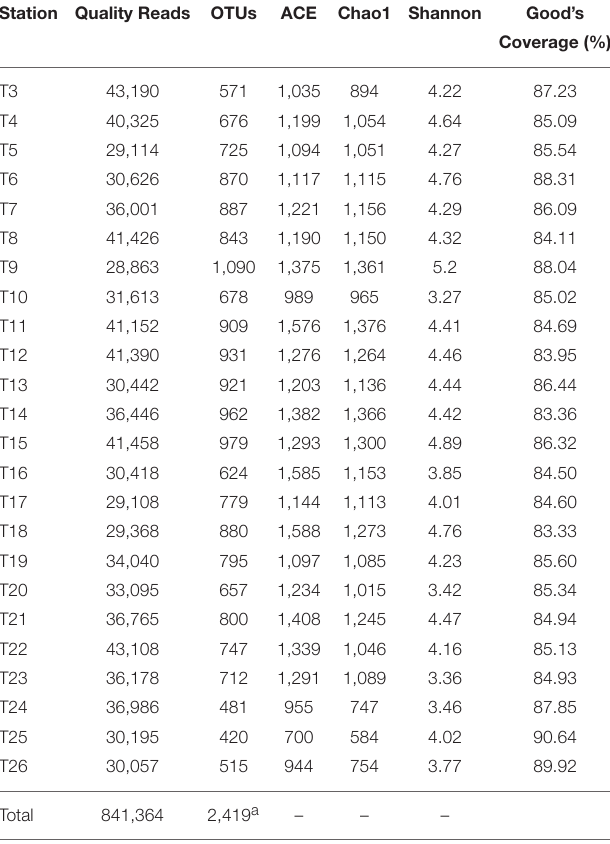
TABLE 1 | Diversity indices and richness estimators of the surface marine